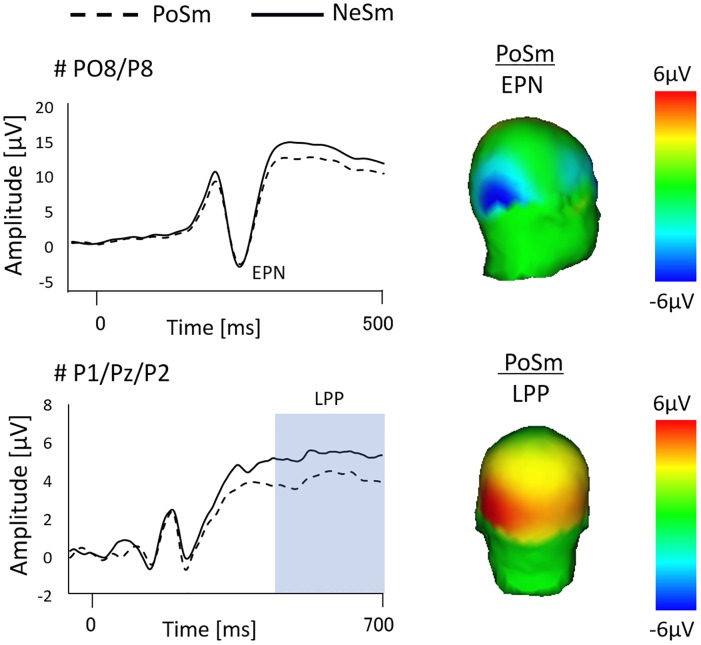
Illustration of the ERP waveform and the topographical map related to the EPN and LPP.ERP waveforms for the right temporo-occipital (PO8/P8) and parietal sensor (P1-Pz-P2) for PoSm (dashed line) and NeSm (solid line) conditions. Topographical maps display the time interval plotted on a backward right (EPN) and back view (LPP).